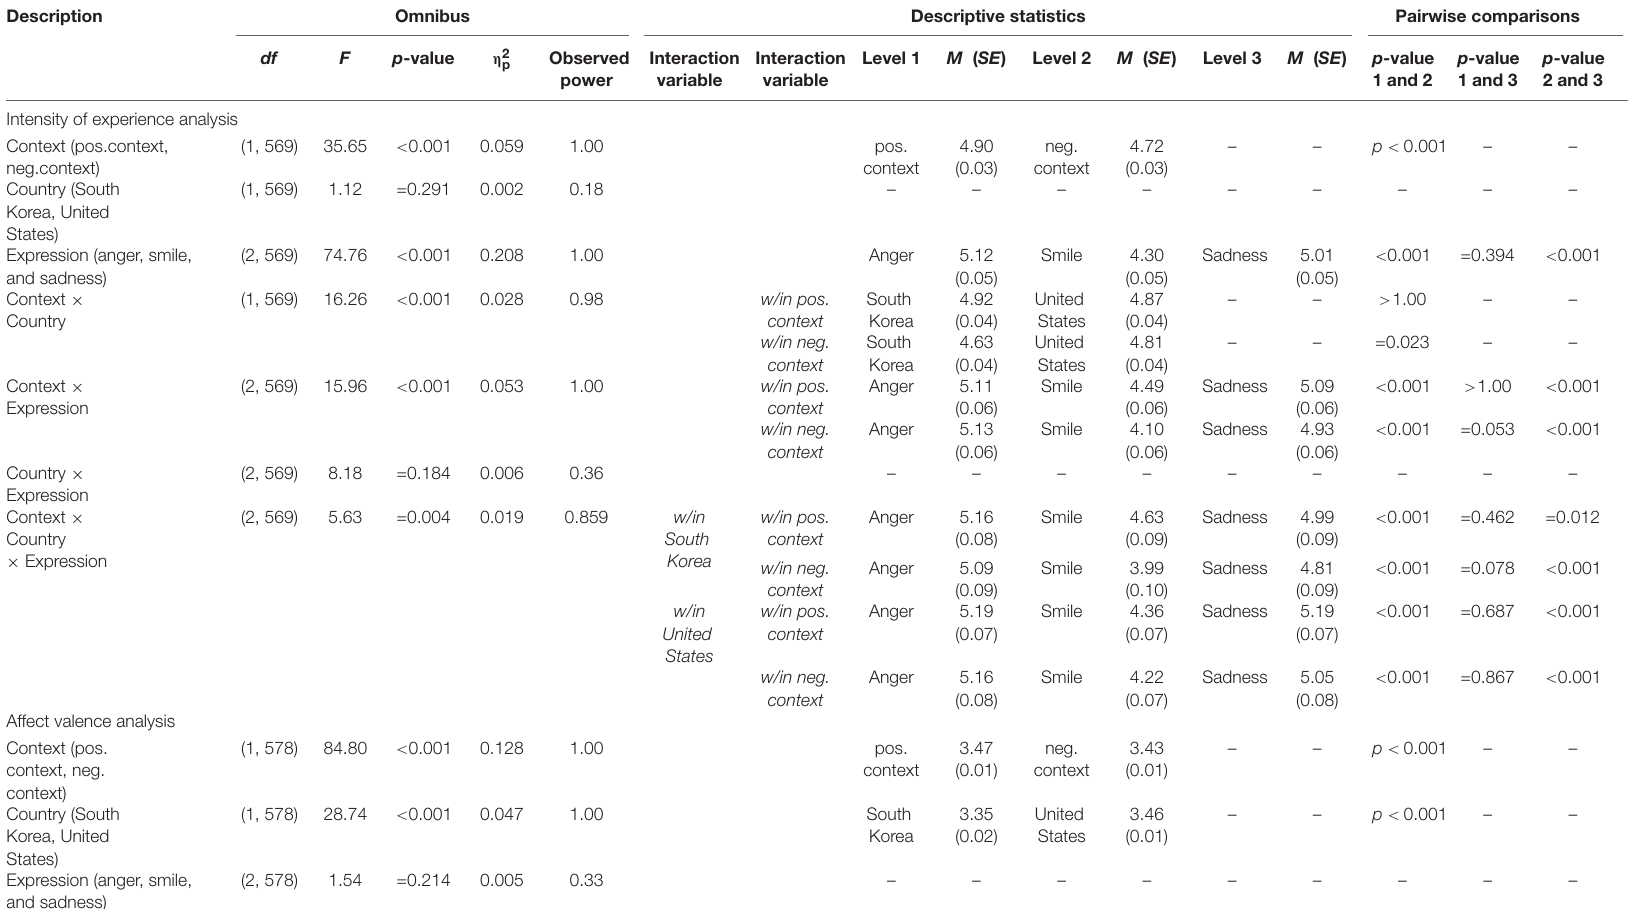
TABLE 3 | General linear repeated measures models testing inferred: intensity and valence of emotion. Description